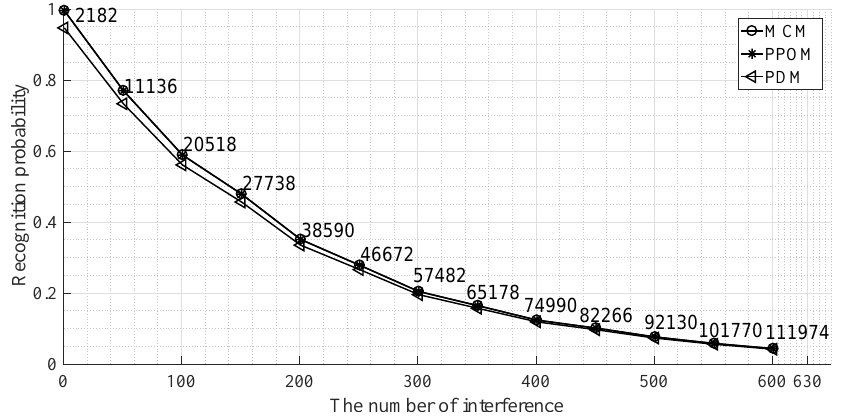
Figure 7. MRP vs the number of interference